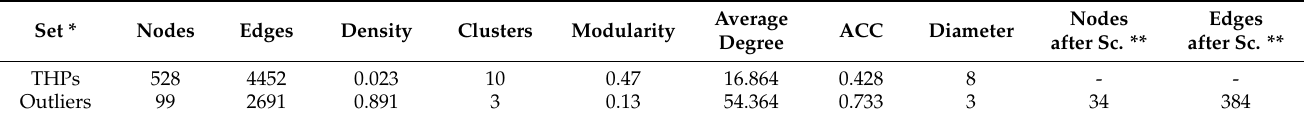
Table 1. Global network properties of CSN of 528 nodes and